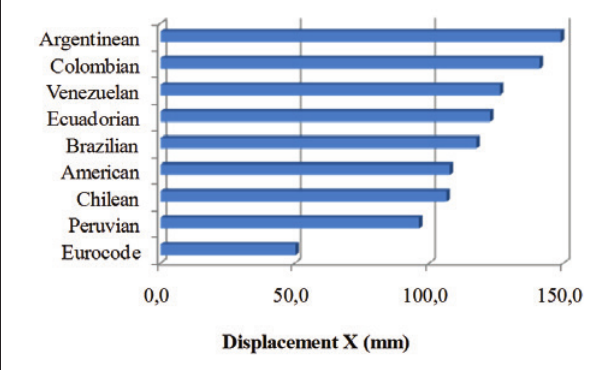
Figure 6 – Obtained displacements, direction X